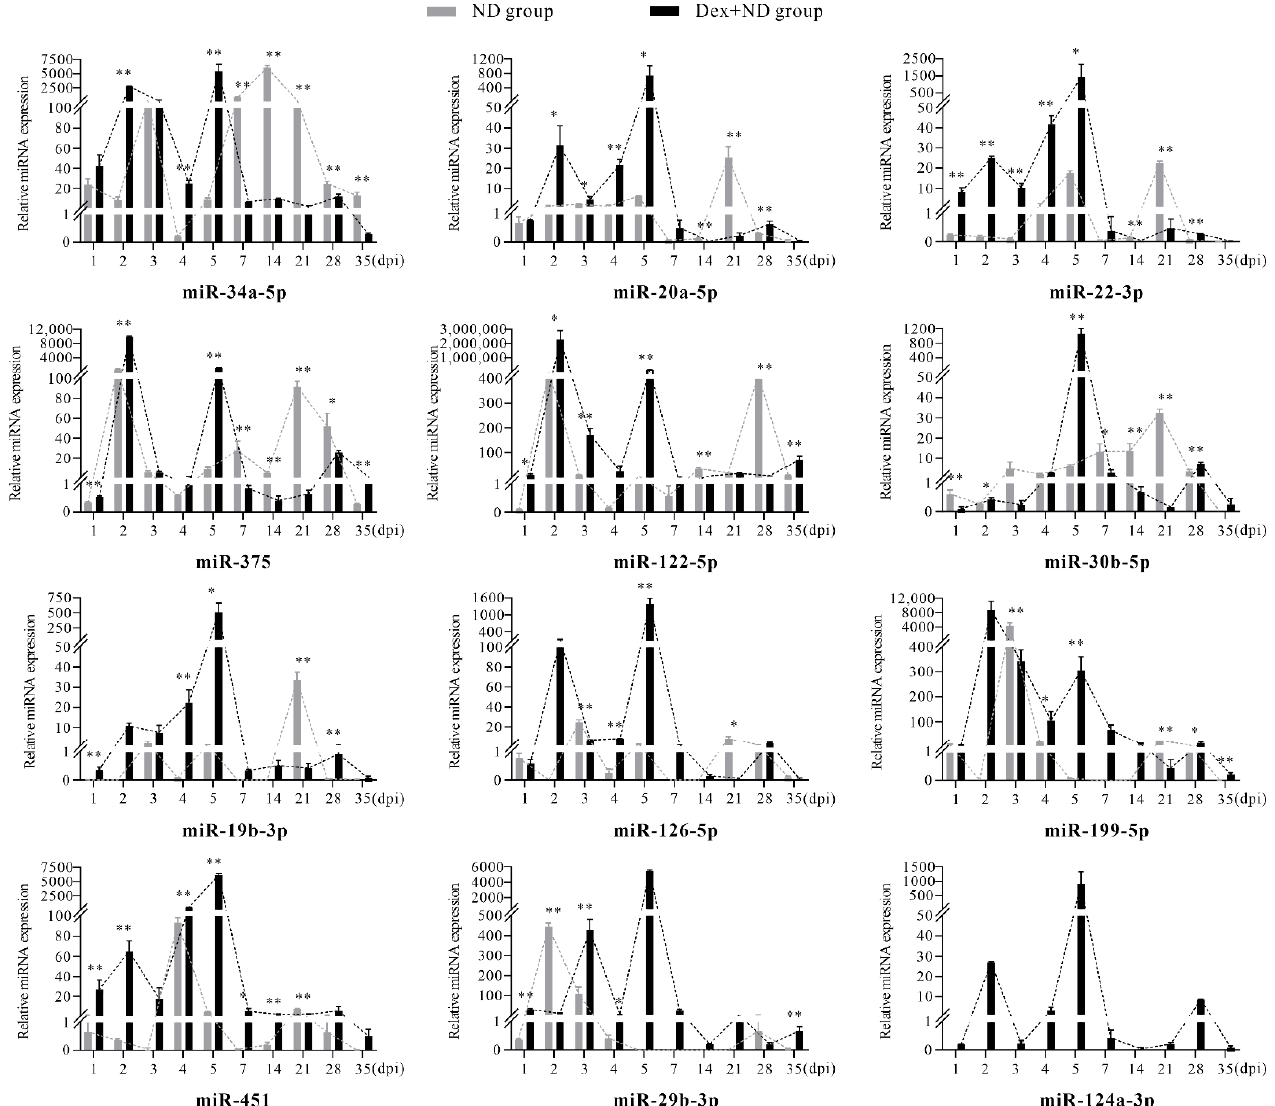
Figure 3. Comparison of the relative expression levels of serum circulating miRNAs between ND group and Dex + ND group. * Significant difference between the two groups ( p < 0.05); ** very significant difference between the two groups ( p < 0.01).